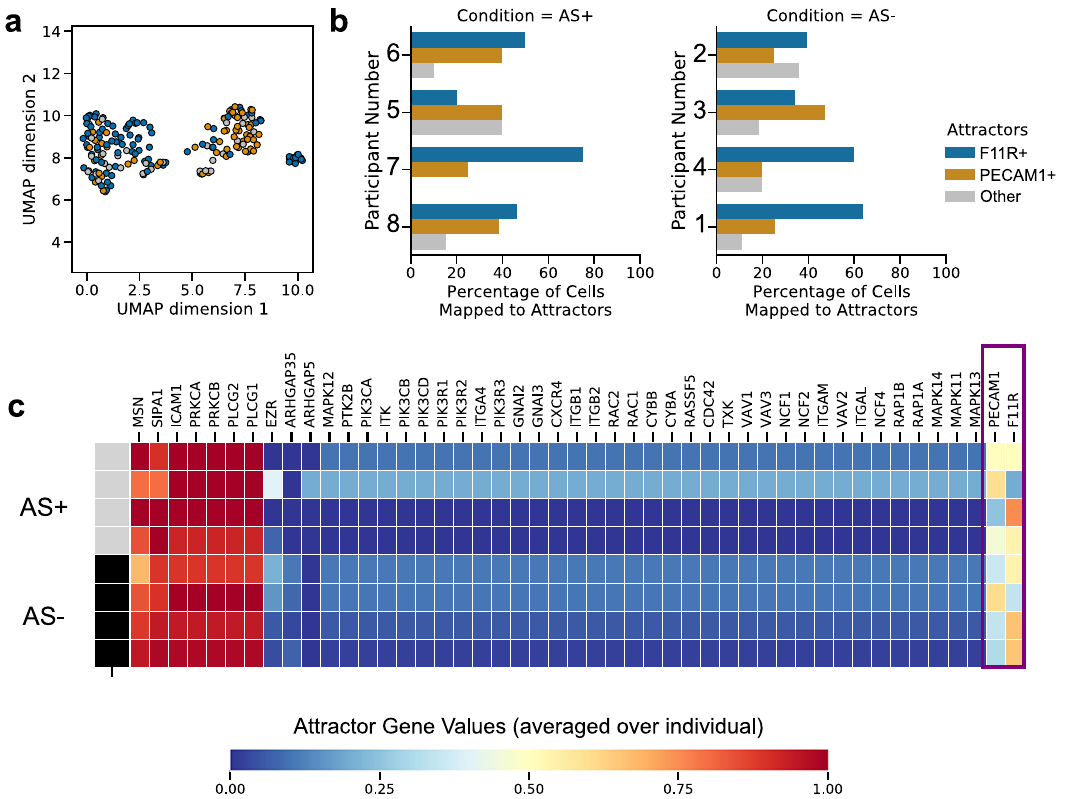
Fig. 6 Monocyte states with respect to the leukocyte transendothelial migration pathway identi fi ed by attractor analysis with scBONITA. a UMAP representation of the cluster of monocytes colored by the attractor to which they are assigned, based on their similarity. The two dominant modes (F11R + and PECAM + attractors) are represented by blue and orange. All other attractors are collectively labeled in gray. b Percentages of monocytes derived from each subject, mapping to the two dominant attractors and all other attractors for the leukocyte transendothelial migration pathway. c Attractor gene values for the leukocyte transendothelial migration pathway trained on monocytes, ranging from 0 (blue) to 1 (red), averaged for each individual subject. The top bar indicates AS + (gray) and AS − (black) subjects. The genes that differ between the two dominant attractors F11R + and PECAM + are highlighted by a violet